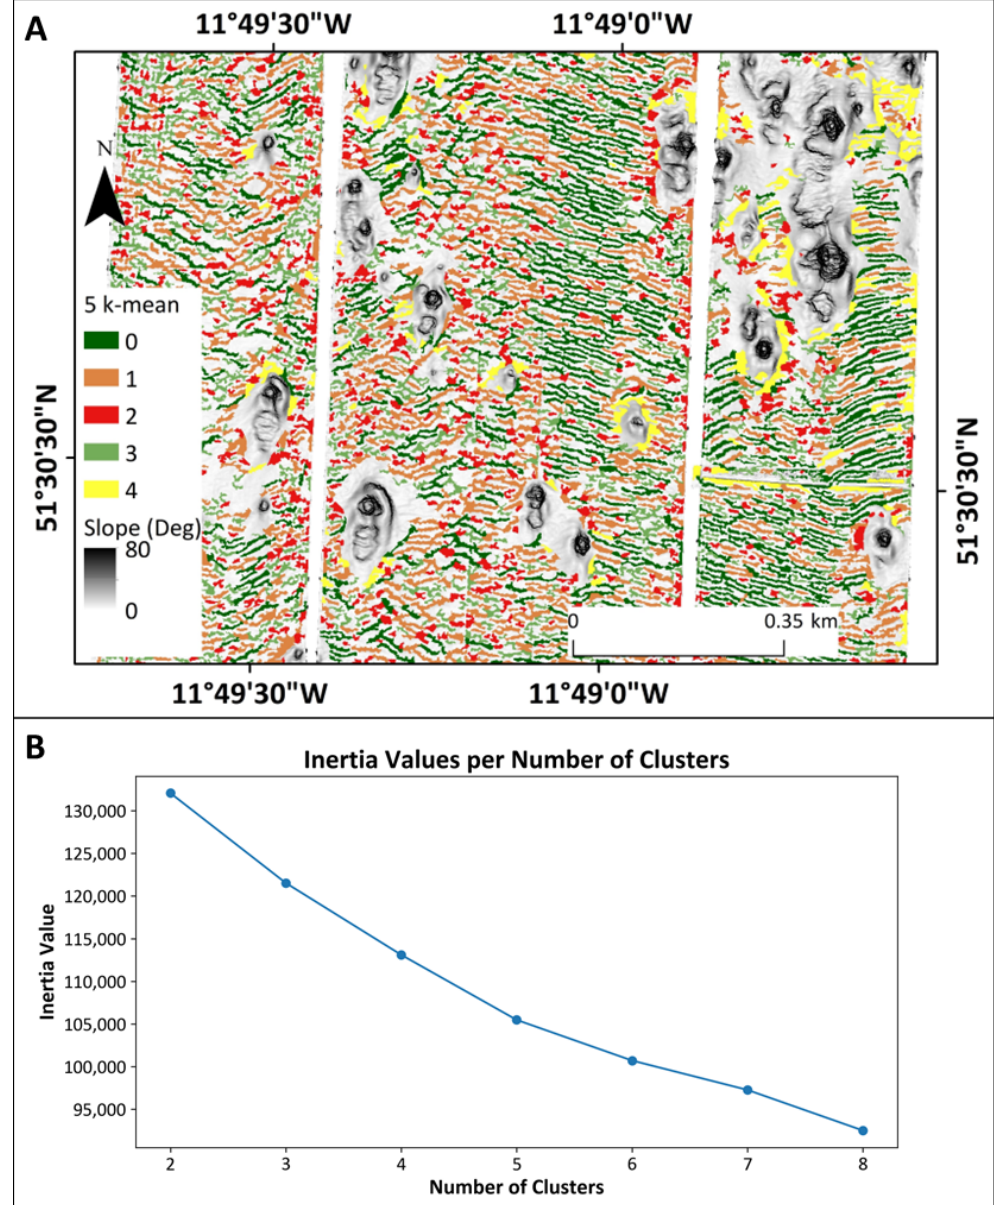
Figure 5. Displaying ( A ) the slope image layer and the product of the 5 k-means classification of morphology, spatial density, and mean bathymetric derivative, ( B ) inertial values for each value of k.